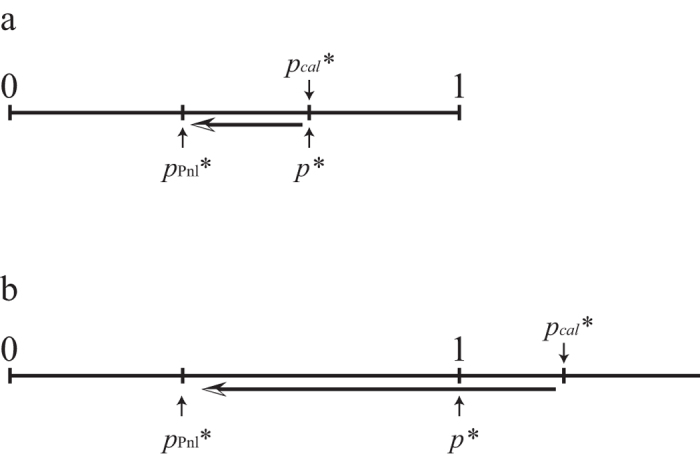
Comparison between conventional ESS and ESS with penalty.(a) The case of calculated ESS without penalty lays between 0 and 1 (pcal* = p*). (b) The case of calculated ESS without penalty exceeds 1 (pcal* > p* = 1).